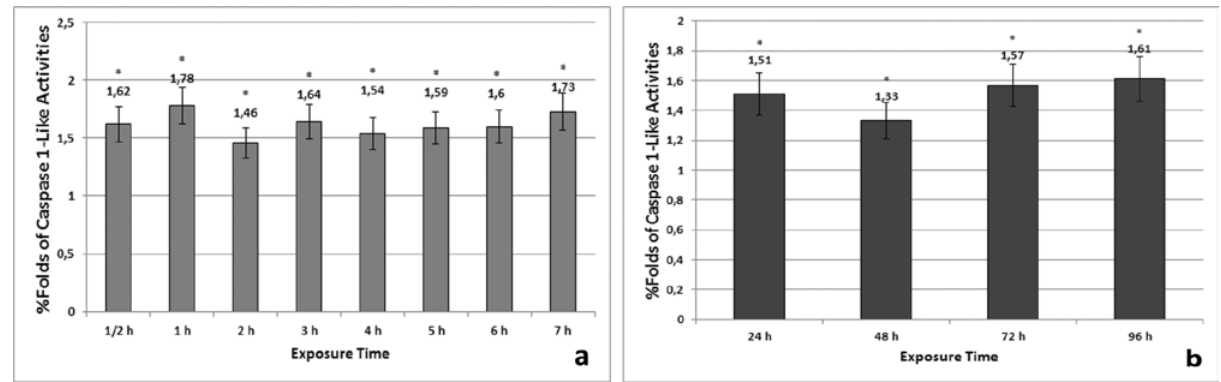
Figure 4. % fold caspase-1 like activities of control and 100 µM AlCl 3 treated barley roots at short (a) and long (b) time points. The data with (*) are significantly different from the control at P < 0.05 level.